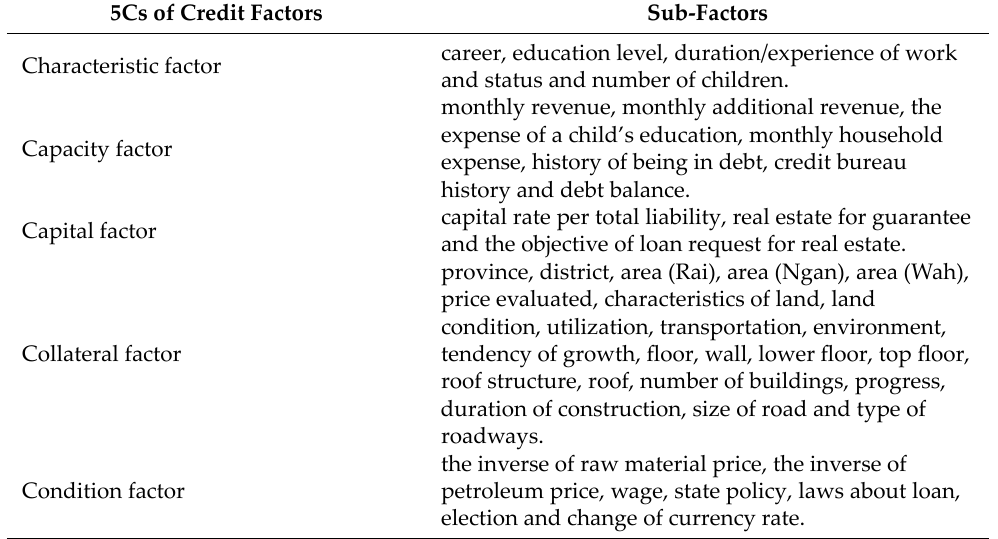
Table 5. 5Cs of credit